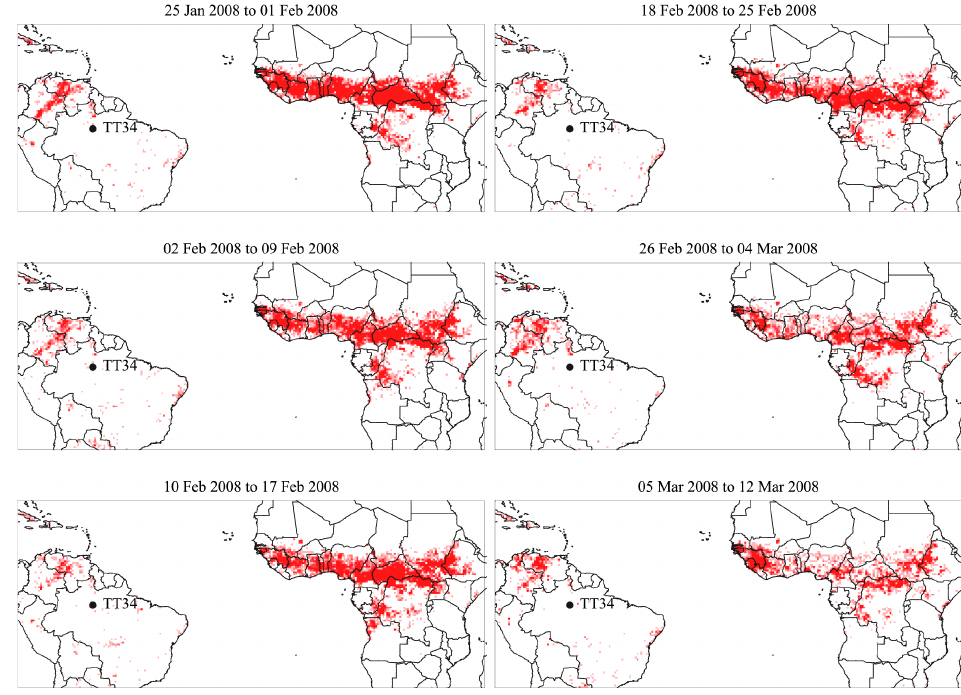
Fig. 6. Gridded statistical summaries of fires over Africa and South America. Panels are prepared using the eight-day composites of the Climate Modeling Grid (CMG) Fire Products of the MODIS Collection-5 Active Fire Product (Giglio et al., 2006). Red is scaled from 0 to 25 pixel fire counts, with corrections for cloud cover. Some pixels have more than 25 fire pixels (e.g., maximum value for scenes shown is 1000 pixel fire counts).